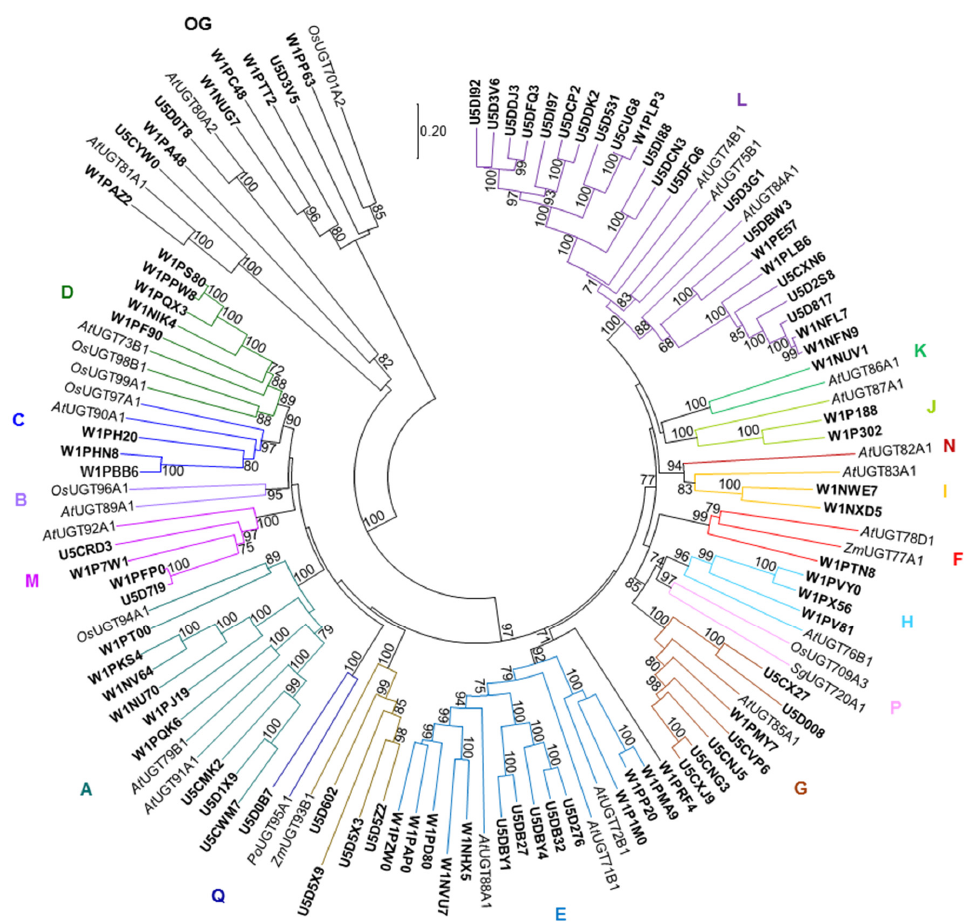
Figure 3. A neighbor-joining tree of Amborella trichopoda UGTs and selected UGTs representing different plant UGT phylogenetic groups. The Amborella UGTs are highlighted in bold. Bootstrap values greater than 60 are shown next to the branches. OG, outgroup.